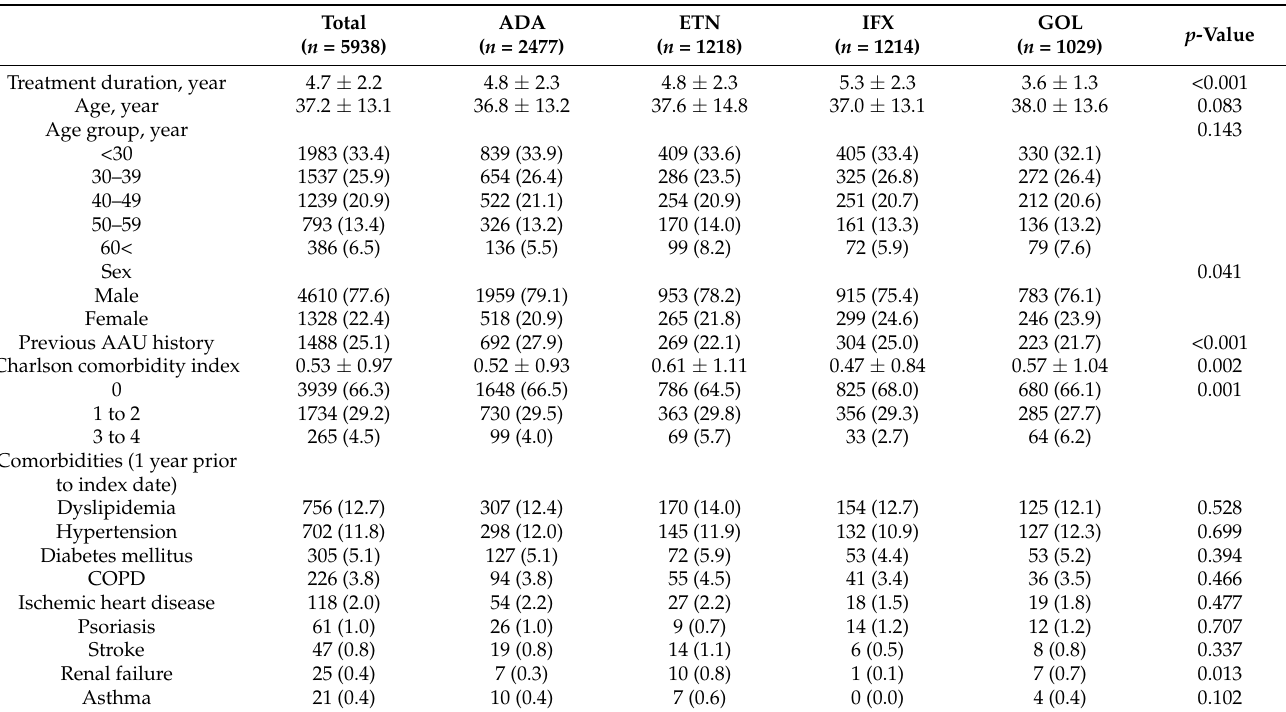
Table 1. Baseline characteristics of TNF- α inhibitor users.